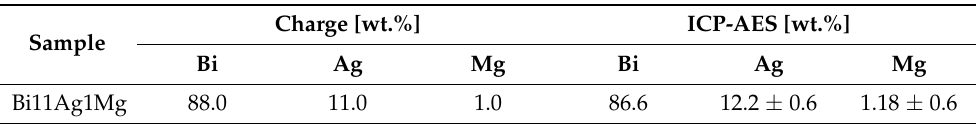
Table 1. Composition of the Bi–Ag–Mg alloy and the results of the chemical analysis performed by the ICP-AES method [wt.%]. the ICP-AES method [wt.%].